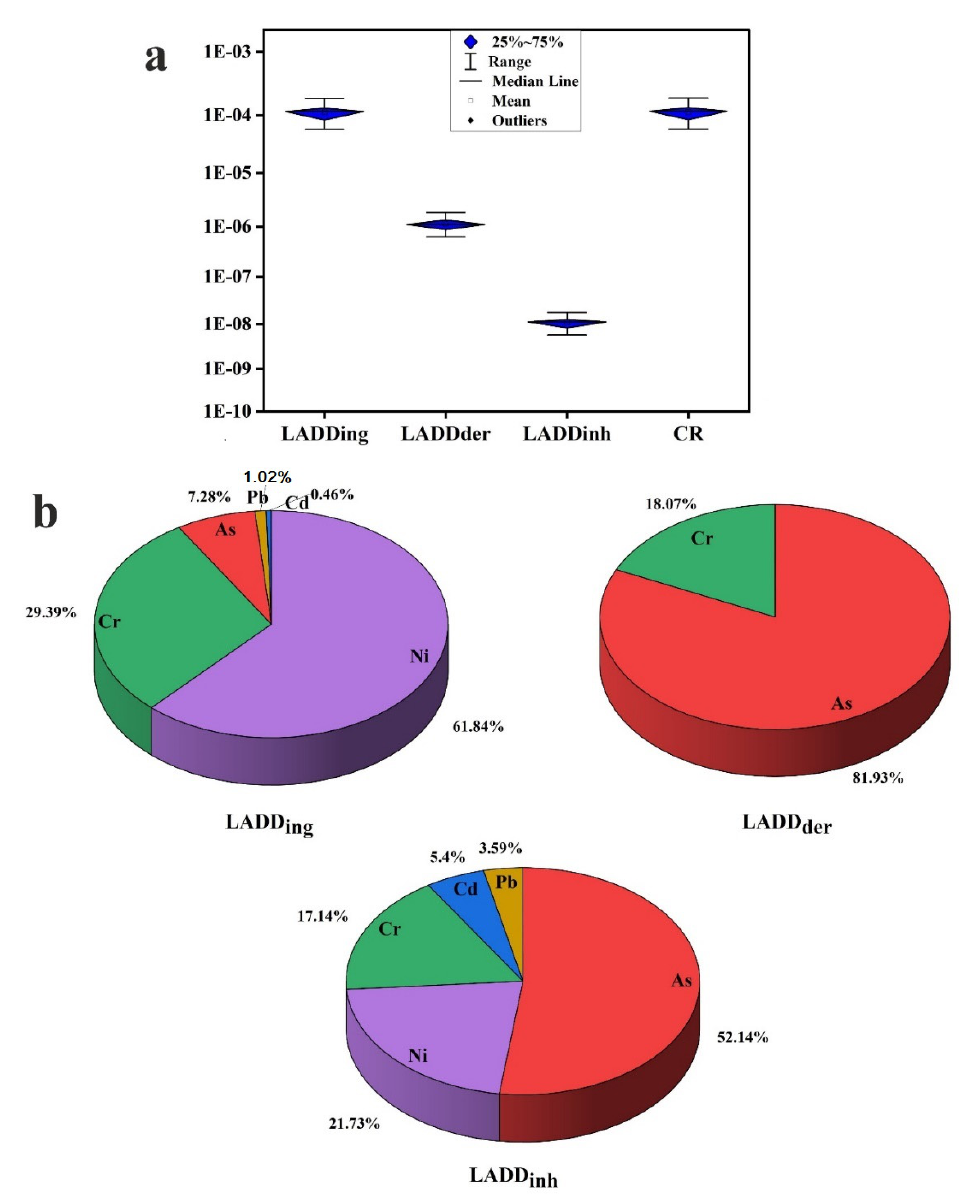
Figure 8. ( a ) Boxplots of cancer risk; ( b ) pie chart showing individual element contribution (%) for cancer risk.